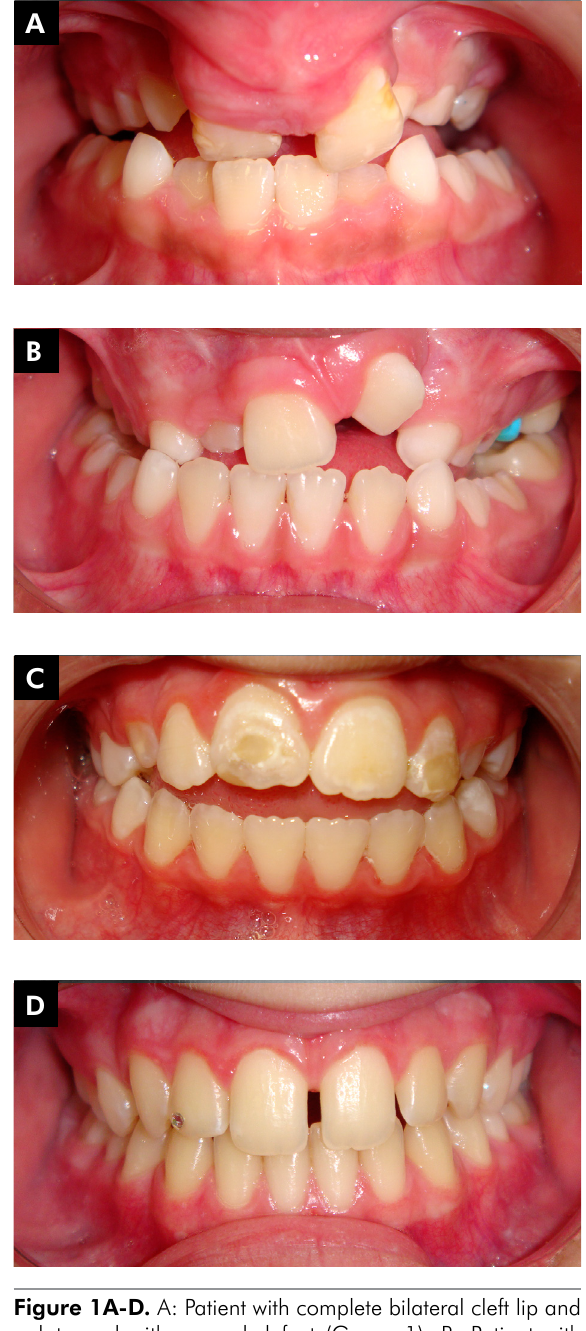
Figure 1A-D. A: Patient with complete bilateral cleft lip and palate and with enamel defect (Group 1); B: Patient with complete unilateral cleft lip and palate and without enamel defect (Group 2); C: Patient without cleft lip and palate and with enamel defect (Group 3); D: Patient without cleft lip and palate or enamel defect (Group